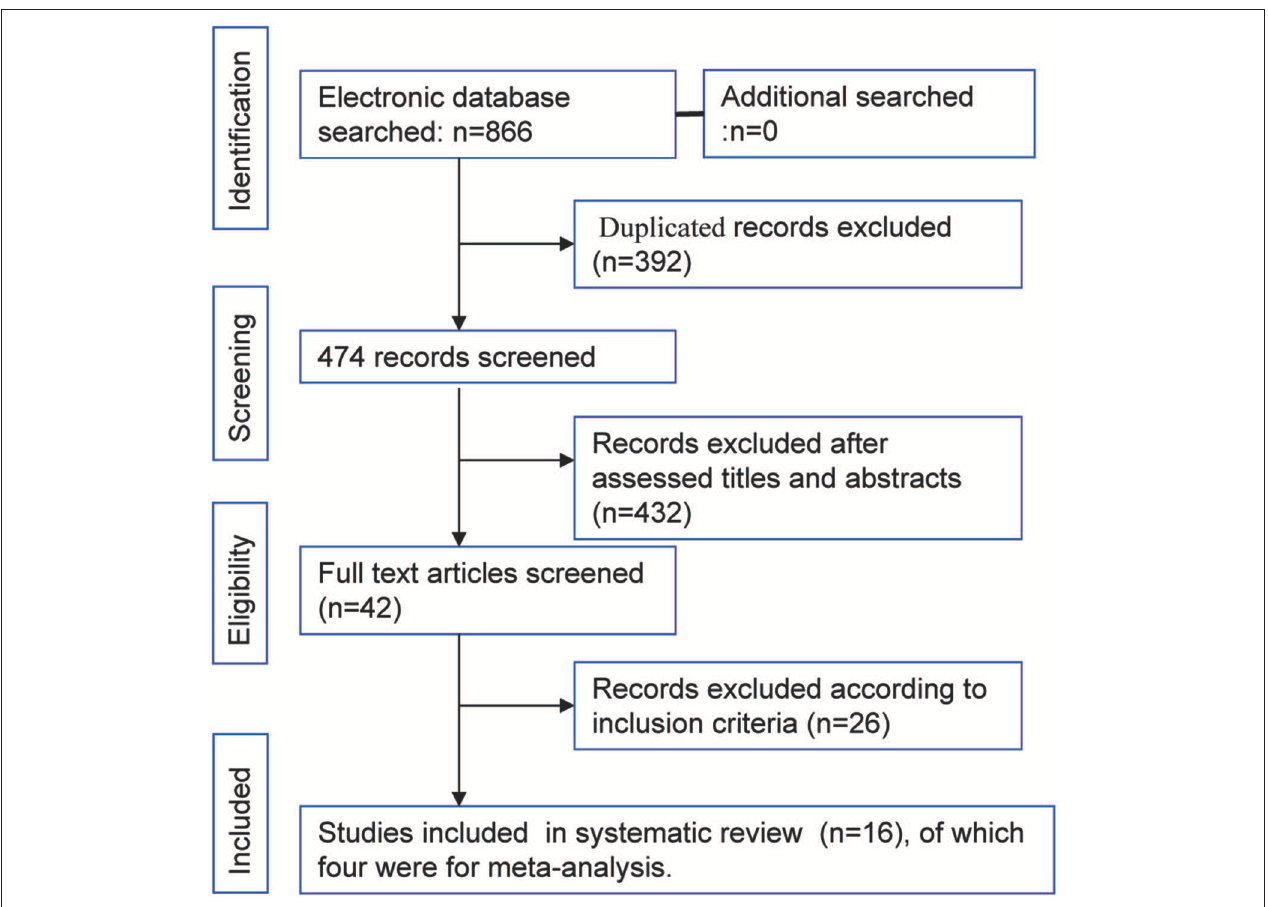
FIGURE 1 | The study selection